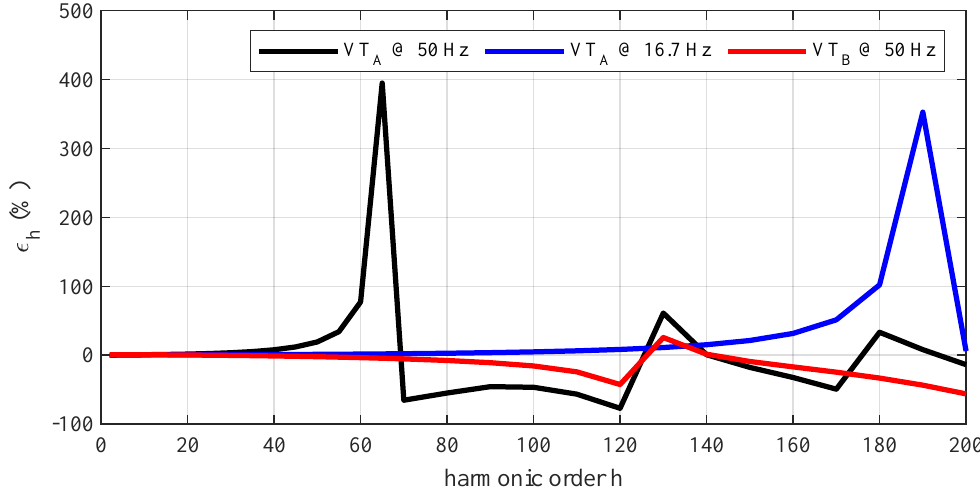
Figure 2. Harmonic ratio error measured under the FH1 test performed on VT A at 50 Hz, VT A at 16.7 Hz, and VT B at 50 Hz.